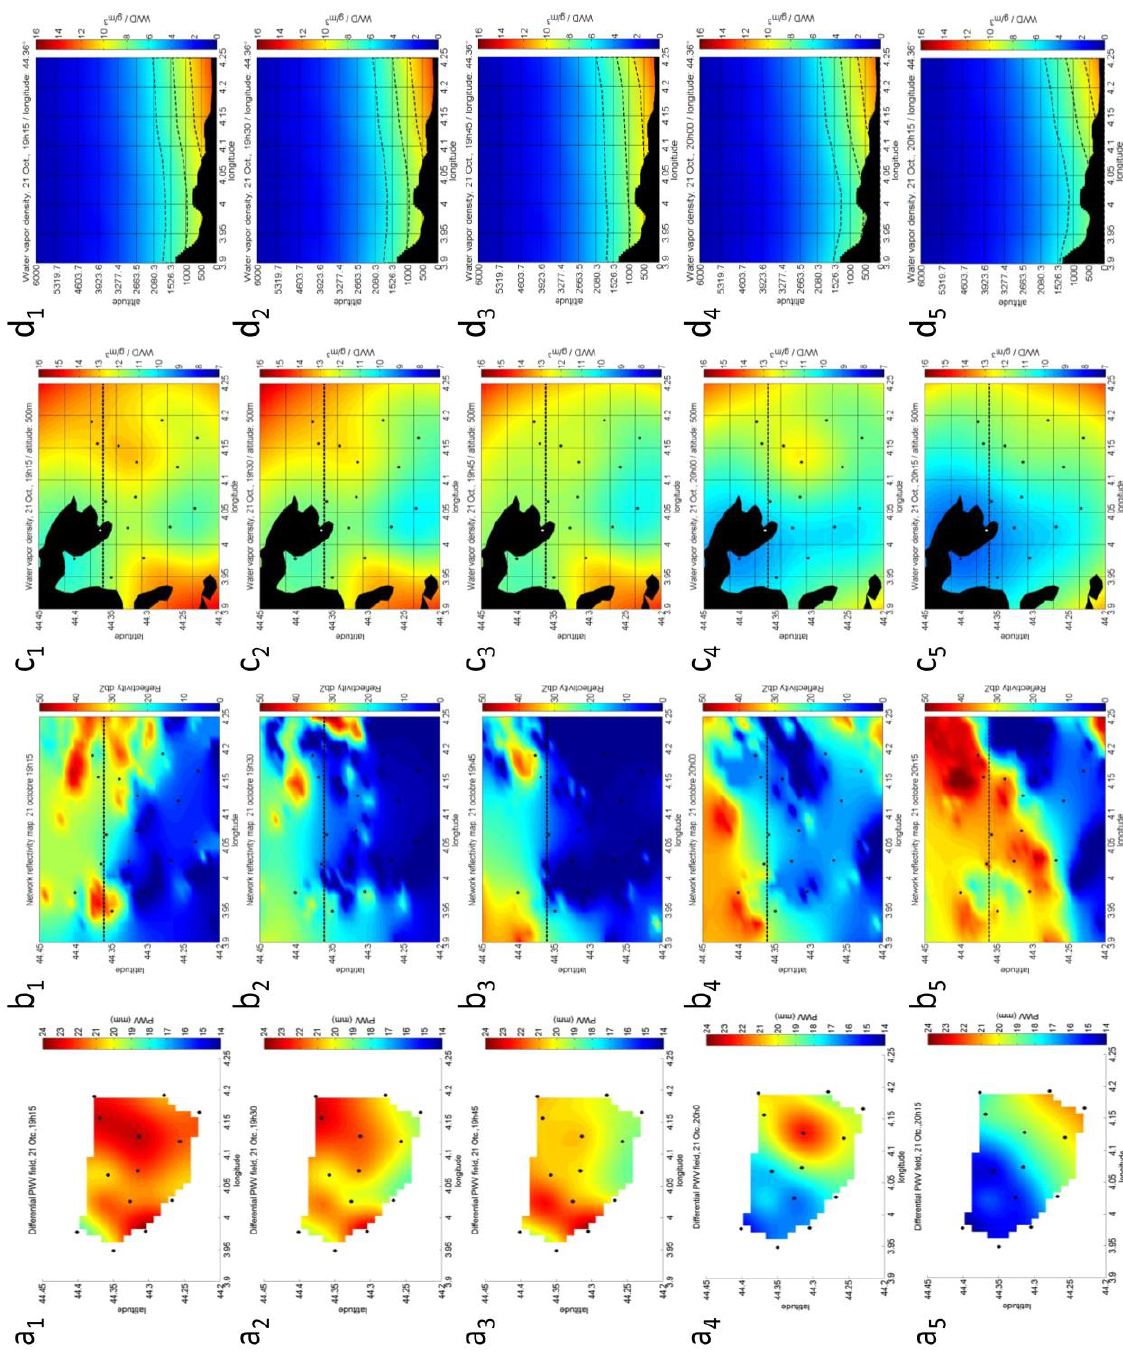
Figure 15: a) The differential PWV field (with respect to the epoch on the 8th of October at 00h00) over 4 Fig. 15. (a) The differential PWV field (with respect to the epoch on 8 October at 00:00UTC) over our dense local network on the 21 Oc- tober 2002 from 19:15 to 20:15, in 15min time steps. The units aremm; (b) Corresponding radar reflectivity fields in dbZ from the Bollène our dense local network on the 21st of October 2002 from 19h15 to 20h15, in 15 min time steps. The units 5 Radar; (c) Corresponding water vapour density (gm − 3 ) on horizontal cross sections (altitude 500m). The dashed line indicates the location are mm; b) Corresponding radar reflectivity fields in dbZ from the Bollène Radar; c) Corresponding 6 of the (d) profile; (d) Water vapour density (gm − 3 ) on vertical cross sections (west-east oriented). Lines of constant water vapour density of 10, 8 and 6gm − 3 are represented by dashed lines. In (a) , (b) and (c) , the black dots indicate GPS station positions. In (c) and (d) , the black water vapour density (g/m 3 ) on horizontal cross sections (altitude 500 m). The dashed line indicates the 7 lines represent the voxel limits, and the relief is indicated in black. The dashed line in (b) and (c) indicates the profile shown in (d)